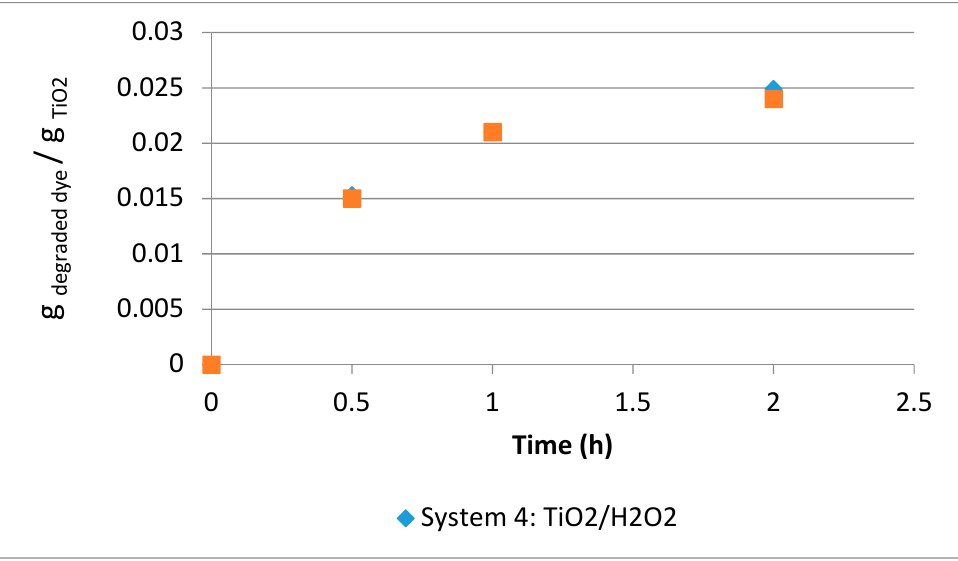
Figure 17. Comparison of the dye degradation curves for Systems 1 and 4.